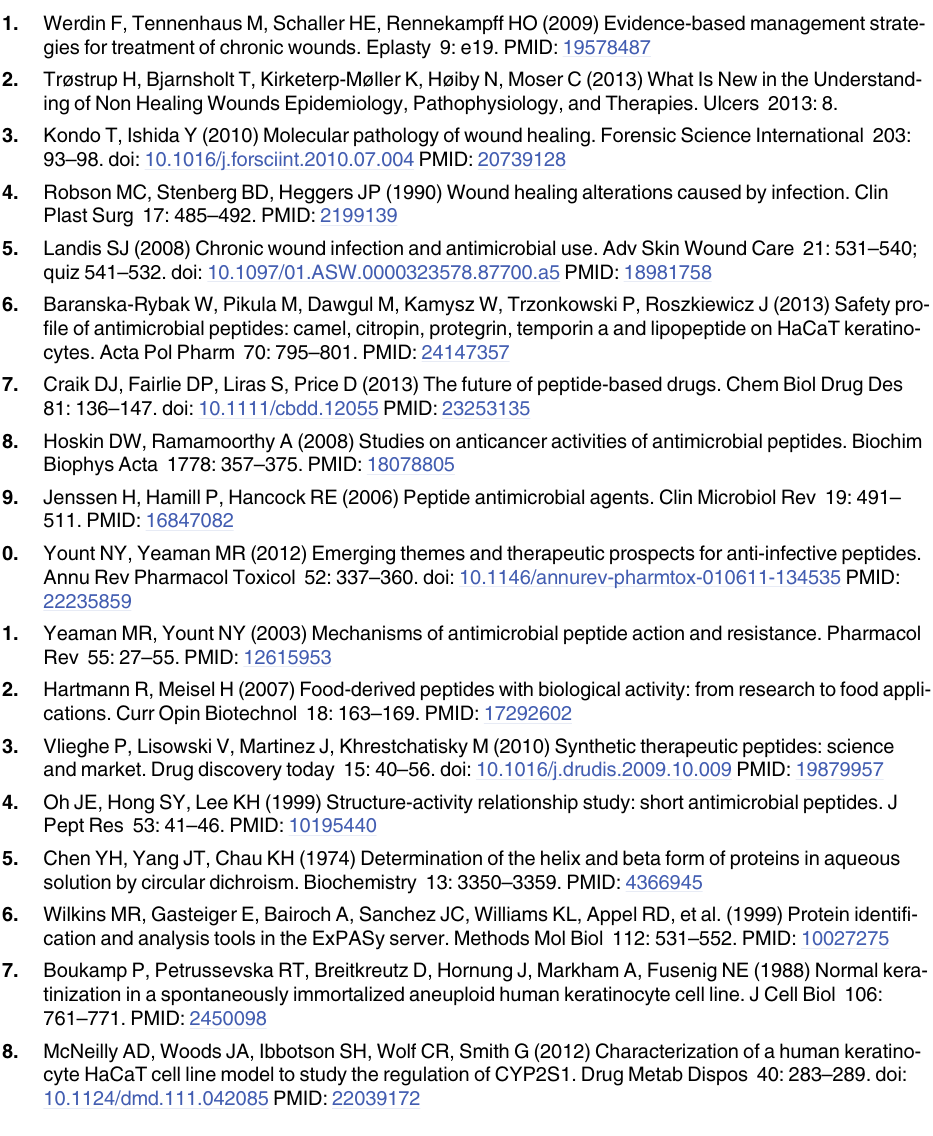
S1 File. Table A: List of peptides used in the design of conjugates with characteristics of their biological properties. Figure A: CD spectra of the selected peptides described in the arti-